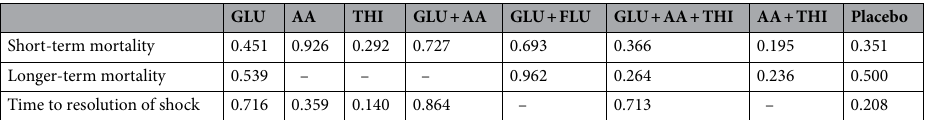
Table 1. P-score statistics. GLU Glucocorticoid, AA ascorbic acid, THI Thiamine, FLU